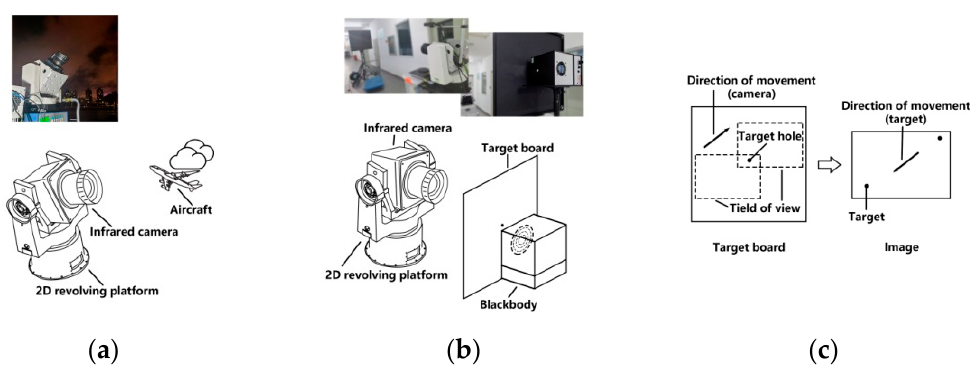
Figure 6. Experimental data acquisition details ( a ) gathering method of the sky background, ( b ) semi-physical simulation method of deep space background, ( c ) the detail of how the IRPT moves in deep space background of semi-physical simulation.